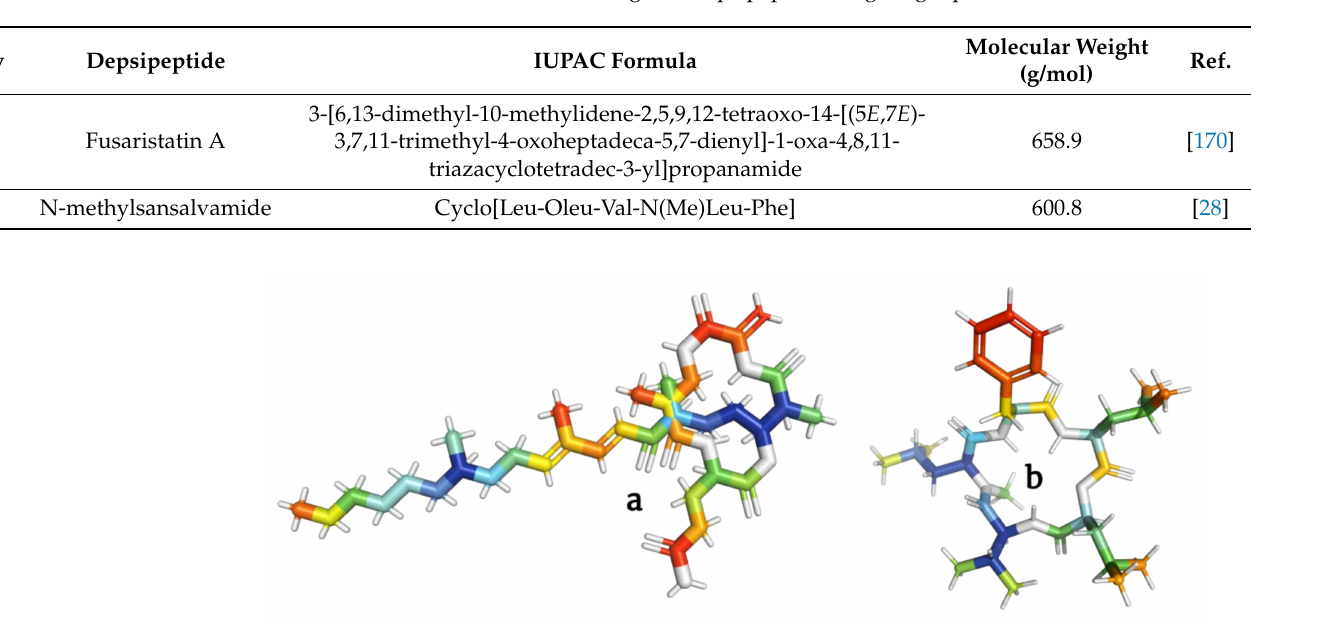
Table 7. Formula and molecular weight of depsipeptides targeting topoisomerases in tumor cells.